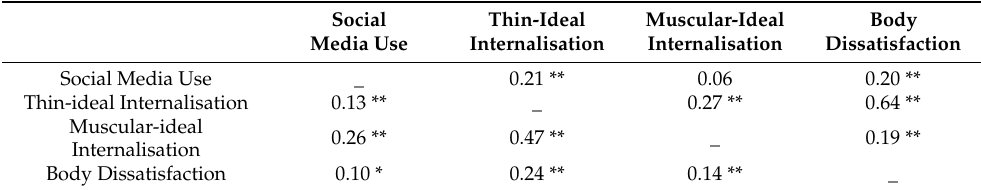
Table 2. Spearman Correlations between Social Media Use, Thin-Ideal Internalisation, Muscular-Ideal Internalisation and Body Dissatisfaction, in Boys and